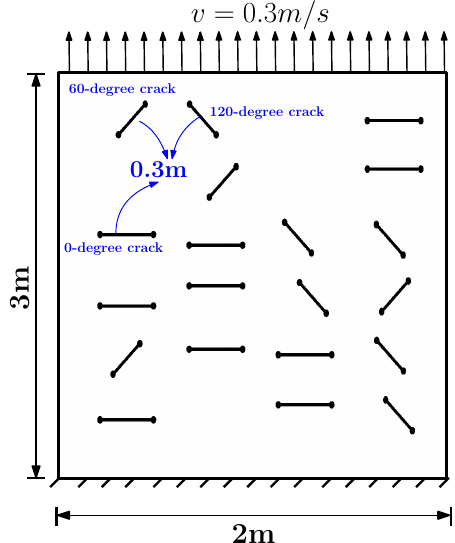
Figure 2. Initial boundary value problem: A pictorial description of the HOSS simulation setup for a problem with 20 pre-existing cracks. 190 high-fidelity HOSS simulations were performed. For each simulation, the location and orientation of the initial cracks were randomly chosen. Orientations were chosen from 0-degree, 60-degree, or 120 degrees. Loading conditions, material parameters, and domain dimensions are unchanged for all 190 HOSS